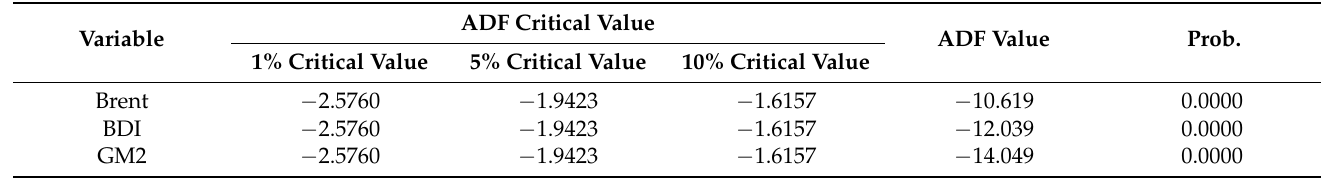
Table A2. Results of stationary tests for variables.